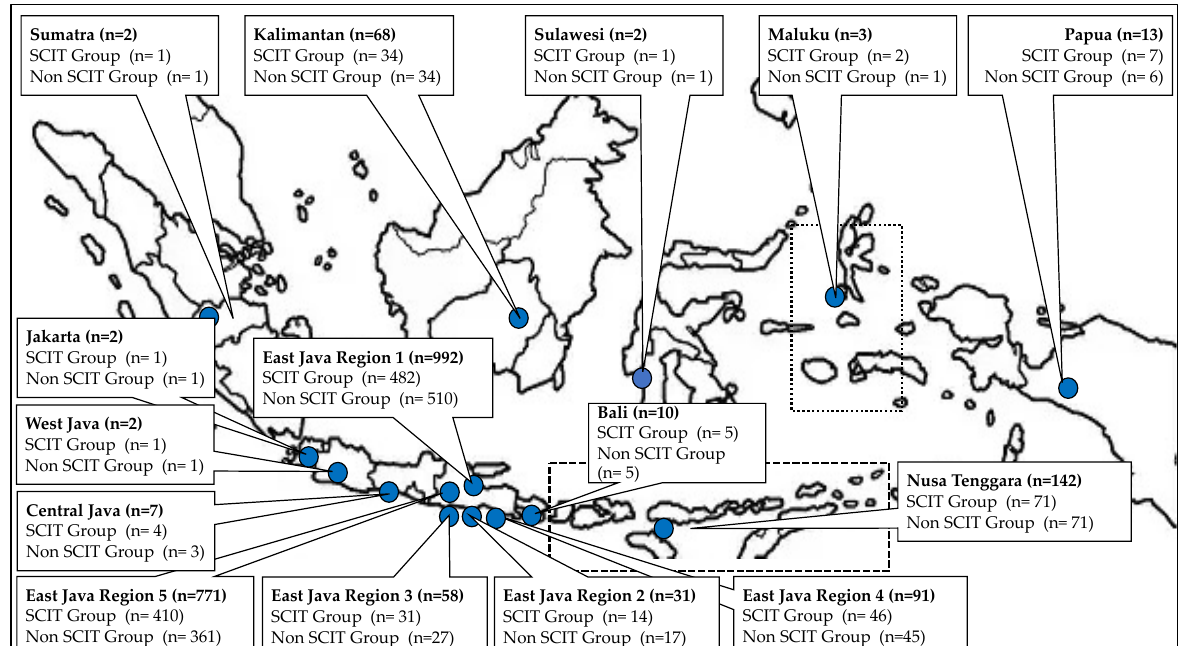
Figure 2. Distribution of 2,196 children with allergic rhinitis were recruited as subjects of this study based on geographic Figure 2. The distribution of the 2196 children with allergic rhinitis that were recruited as subjects of this study based on area in Indonesia (Island, Province or Area) geographic area in Indonesia (Island, Province or